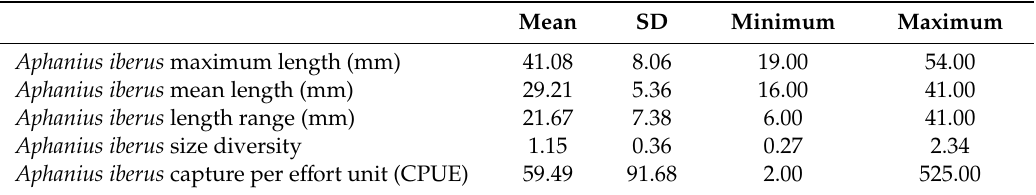
Table 2. A. iberus size metrics and abundance (CPUE) obtained / computed per each sample (N = 49). The descriptive statistics are the mean, standard deviation (SD), minimum and